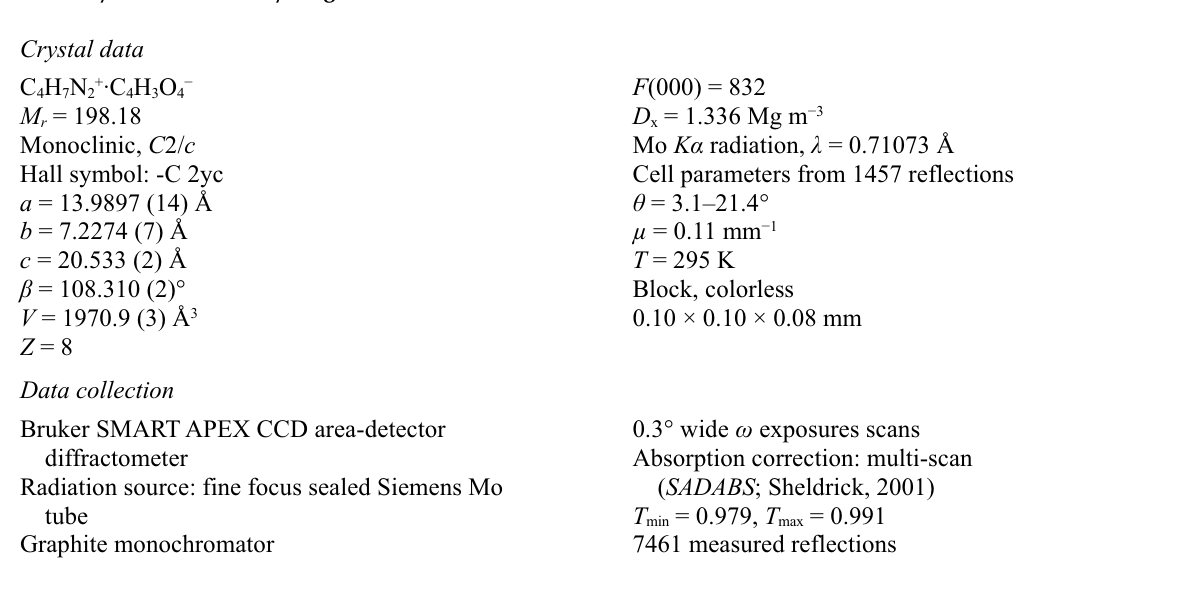
Part of the crystal structure of (I), showing the formation of the two-dimensional corrugated sheet linked by intermolecular N-H···O and C-H···O hydrogen bonds (a) view perpendicular to the (101) plane and (b) view along to the (101) plane, respectively. Only H atoms involved in hydrogen bonds are